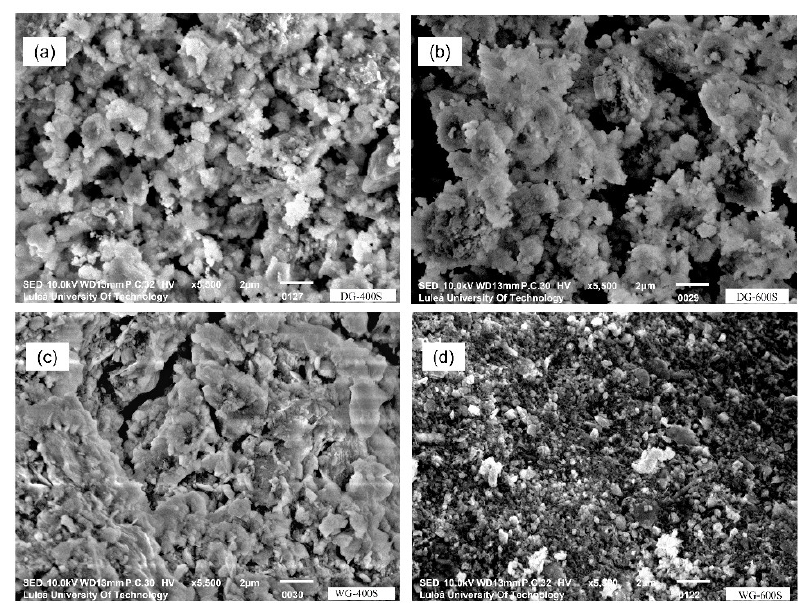
Figure 10. SEM-SE micrographs of Swedish raw clay for samples: ( a ) DG-400S; ( b ) DG-600S; ( c ) WG-400S; ( d ) WG-600S.